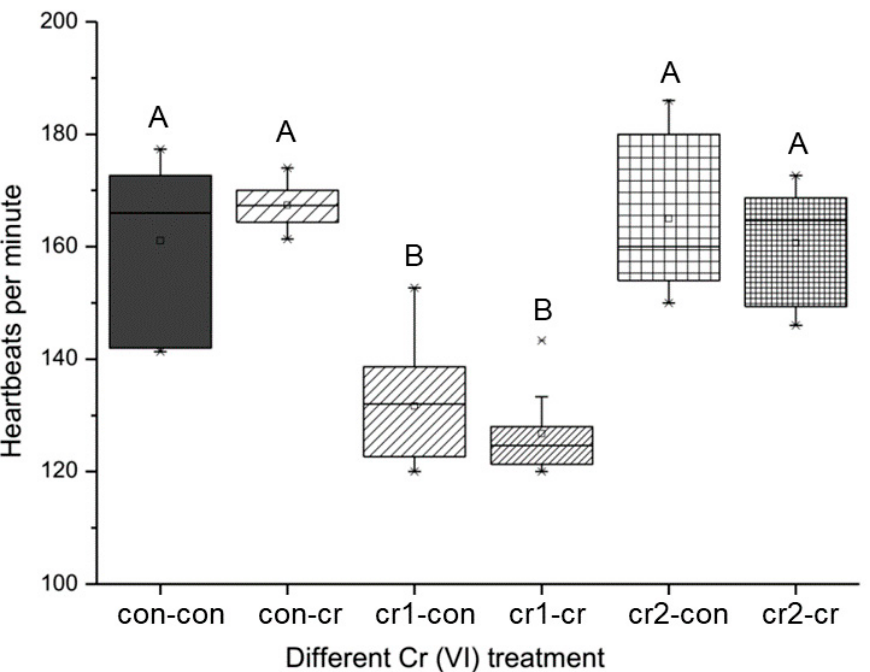
Figure 6. The change of overall heartbeat after long-term Cr(VI) exposure in marine medaka offspring. Different upper case means the significant differences among different treatment ( p ≤ 0.001). The number of biological samples used for each group is as follows: con-con ( N = 14), con-cr ( N = 25), cr1-con ( N = 9), cr1-cr ( N = 9), cr2-con ( N = 3), cr2-cr ( N = 3).